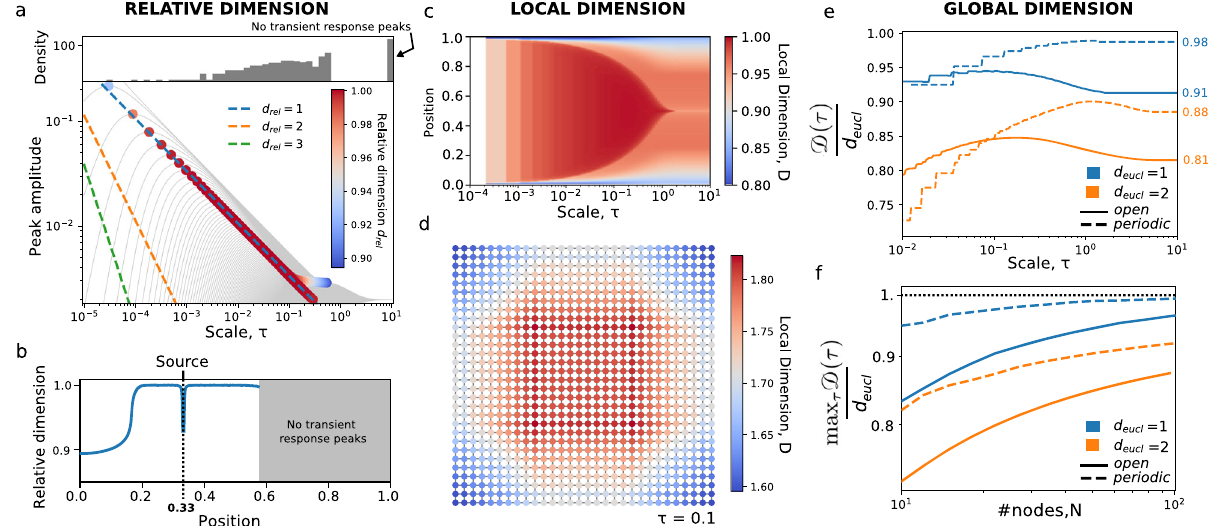
Fig. 1 The relative, local and global dimension. a-c Line graph example with n = 500 nodes representing the interval [0, 1]. a The relative dimension of nodes given a source located at x = 0.33. The grey lines are the transient responses of the (non-source) nodes and the position of the peaks in the transient responses are highlighted by dots, coloured by their relative dimension. Top inset, a histogram of transient response peaks where the far right bin corresponds to nodes where no peak in the transient response was observed, and thus no relative dimension could be calculated. b The relative dimension as a function of position in [0, 1] shows a plateau near d rel = 1 for nodes near the source. The grey region indicates the set of nodes for which no peak was observed. c The local dimension of each node as a function of scale, where above τ = 1, the stationary state is attained and the local dimension is stable. d The local dimension of the grid graph ( n = 500) at scale τ = 0.1, showing inhomogeneities due to the boundaries similar to the line graph. e The evolution of the global dimension D ð τ Þ (normalised by the expected Euclidean dimension) as a function of scale for the same line and grid graph as well as their periodic equivalent graphs, illustrating differing behaviours emerging from the in fl uence of the boundaries or the topology. f For the same graphs as in e , we increase the number of nodes in each dimension to measure the convergence rate of max τ D ð τ Þ to the underlying Euclidean dimension d eucl , showing a faster convergence for lower dimensional spaces and periodic